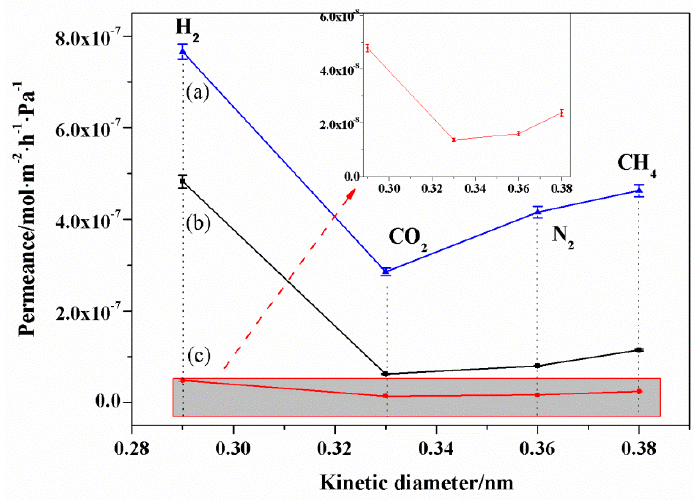
Figure 10. Gas permeance through (a) the original, (b) the AgNO 3 treated and (c) the KCl solution treated NaA zeolite membrane as a function of the gas kinetic diameter at 25 °C and 2.0 bar. Table 5. The contact angles of the NaA zeolite membrane treated by different cations.